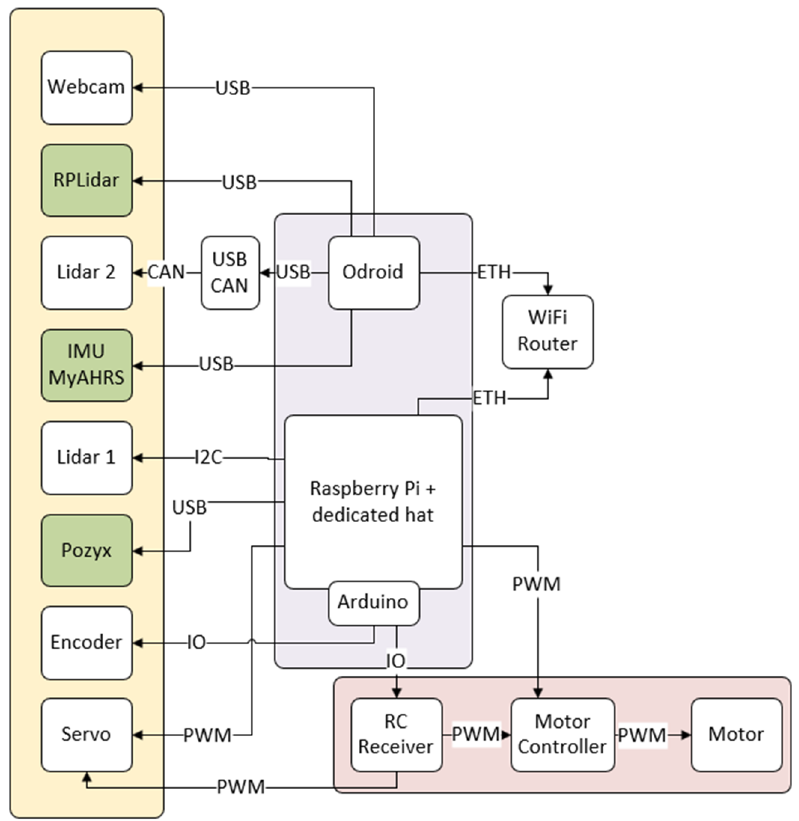
Figure 2. The diagram of connections between used components.